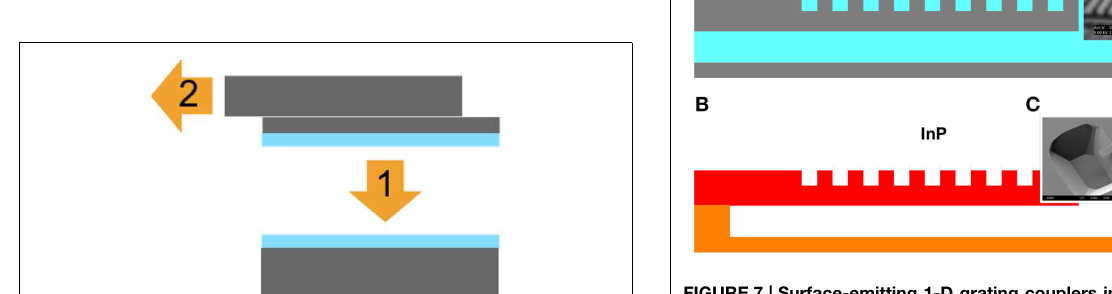
FIGURE 7 | Surface-emitting 1-D grating couplers in silicon (A) and InP (B). In (A) , the gray and light blue represent silicon and silicon dioxide, respectively. In (B) , the red and orange represent InGaAsP and InP, respectively. (C,D) SEM pictures of the InP suspended cantilever grating coupler.